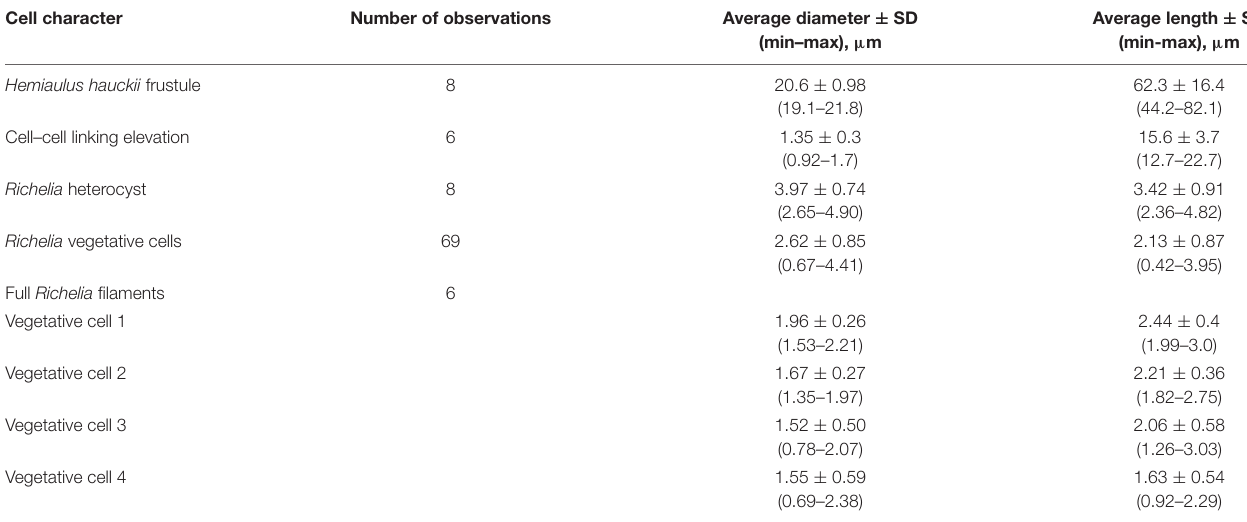
TABLE 1 | Summary of cell measurements from scanning electron microscopy (SEM) and transmission electron microscopy (TEM) micrographs of Hemiaulus hauckii-Richelia intracellularis symbioses.